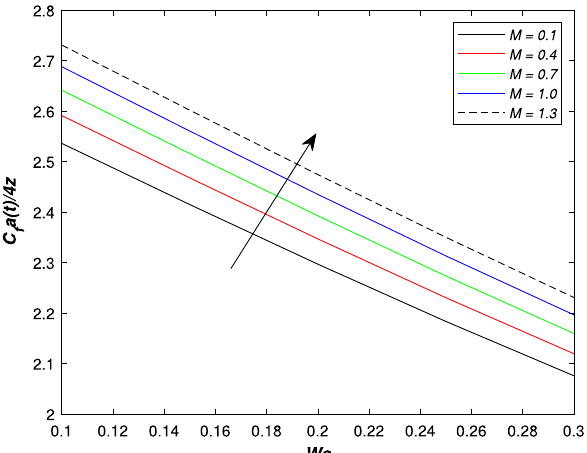
Figure 14. Impact of magnetic parameter M and Weissenber number We on skin friction coefficient.